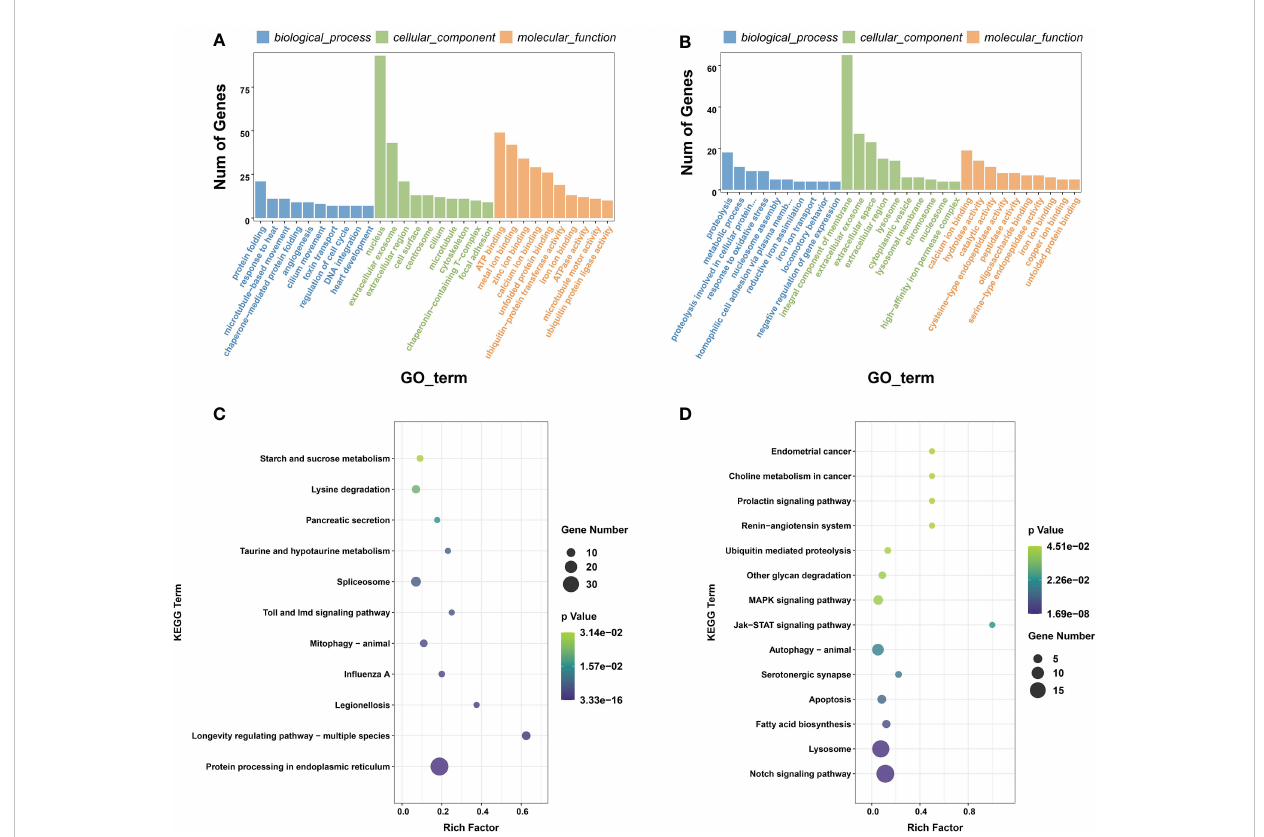
FIGURE 2 (A) GO functional classi fi cation histograms of up-regulated DEGs. (B) GO functional classi fi cation histograms of down-regulated DEGs. (C) Scatter plot showing signi fi cantly enriched KEGG pathways in up-regulated DEGs. (D) Scatter plot showing signi fi cantly enriched KEGG pathways in down- regulated DEGs.